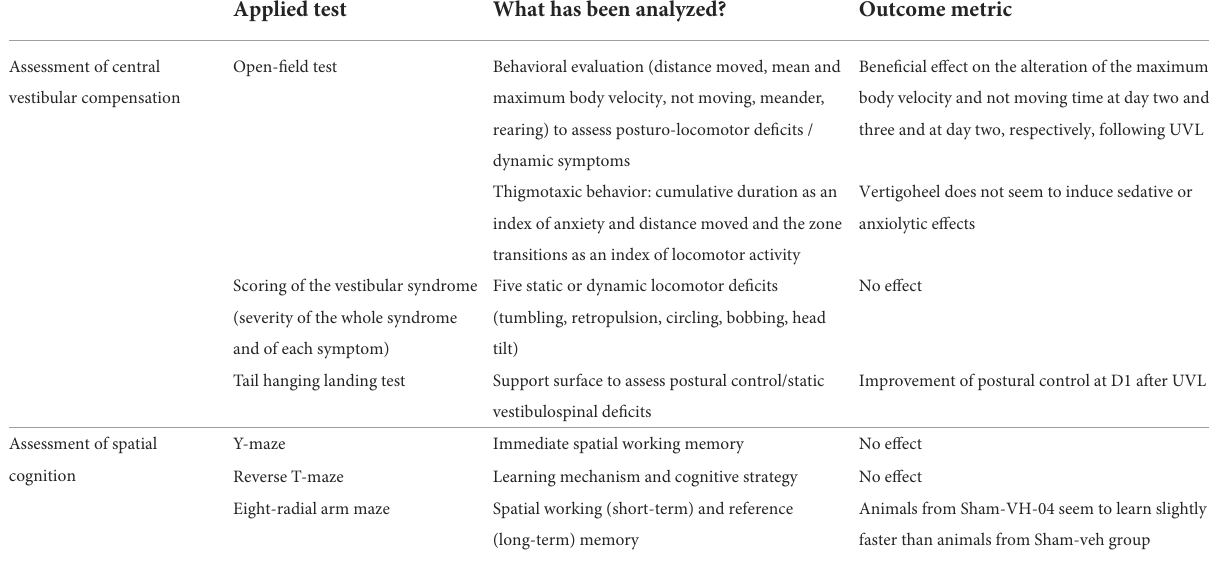
TABLE 2 Summary of the different behavioral assessments and their